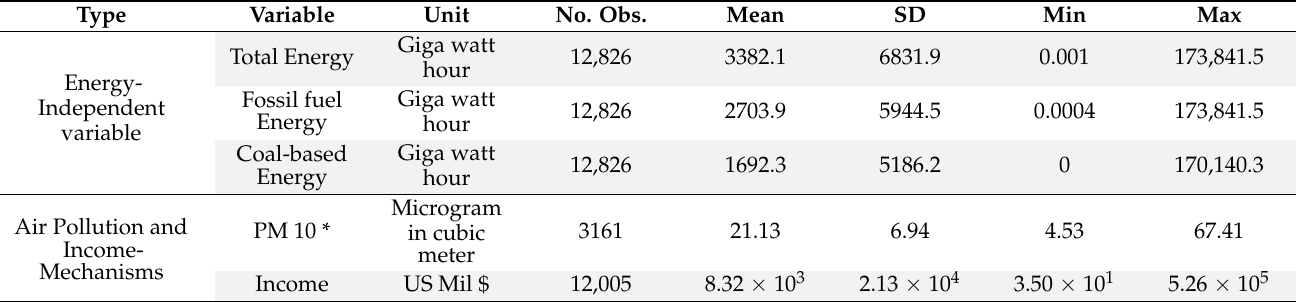
Table 1. Summary statistics of the main variables in the model (2001–2015), at the county